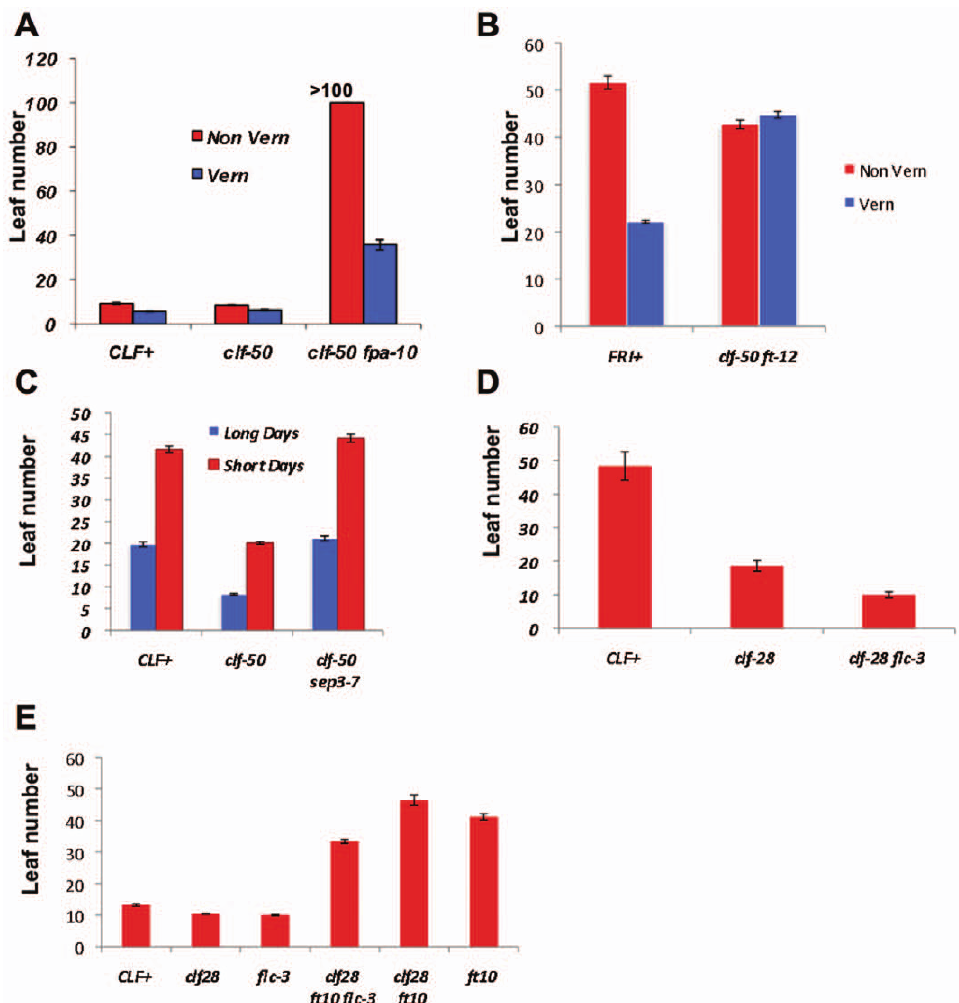
Figure 2. Effects of suppressor mutants upon flowering time. Flowering time was recorded as the number of rosette leaves at bolting, thus late flowering plants have more rosette leaves. Plants were grown in long days unless otherwise stated. Error bars show standard error of mean calculated from at least 10 plants. ( A ) The clf-50 fpa-10 mutant shows a strong vernalization reponse. ( B ) The clf-50 ft-12 mutant does not respond to vernalization treatment. ( C ) The clf-50 sep3-7 mutant flowers at similar time to wild type, thus SEP3 + activity is needed for early flowering in the clf background. ( D ) The flc-3 mutation enhances the early flowering of clf-28 mutants, revealing that FLC activity delays flowering in the clf background. Plants grown in short days, where the effects of clf on flowering time are most obvious ( E ) clf-28 ft-10 mutants flower later than ft-10 mutants due to FLC + activity.